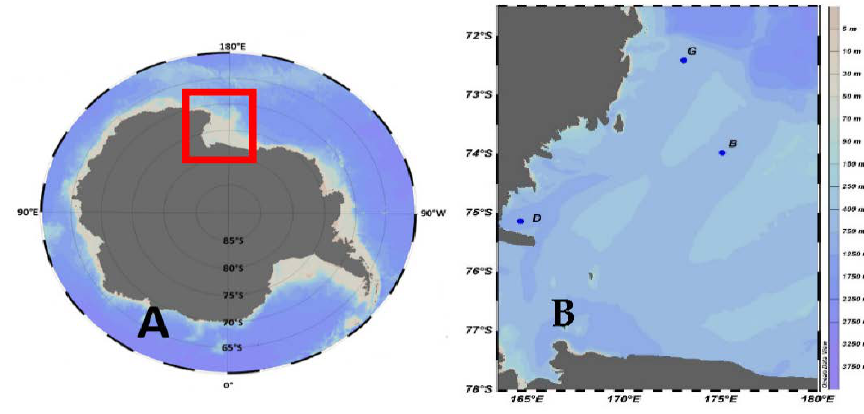
Figure 1. ( A ): Map of Ross Sea; ( B ): position of sampled stations in Ross Sea area. Table 1. Sampling stations and depths for pH analysis.